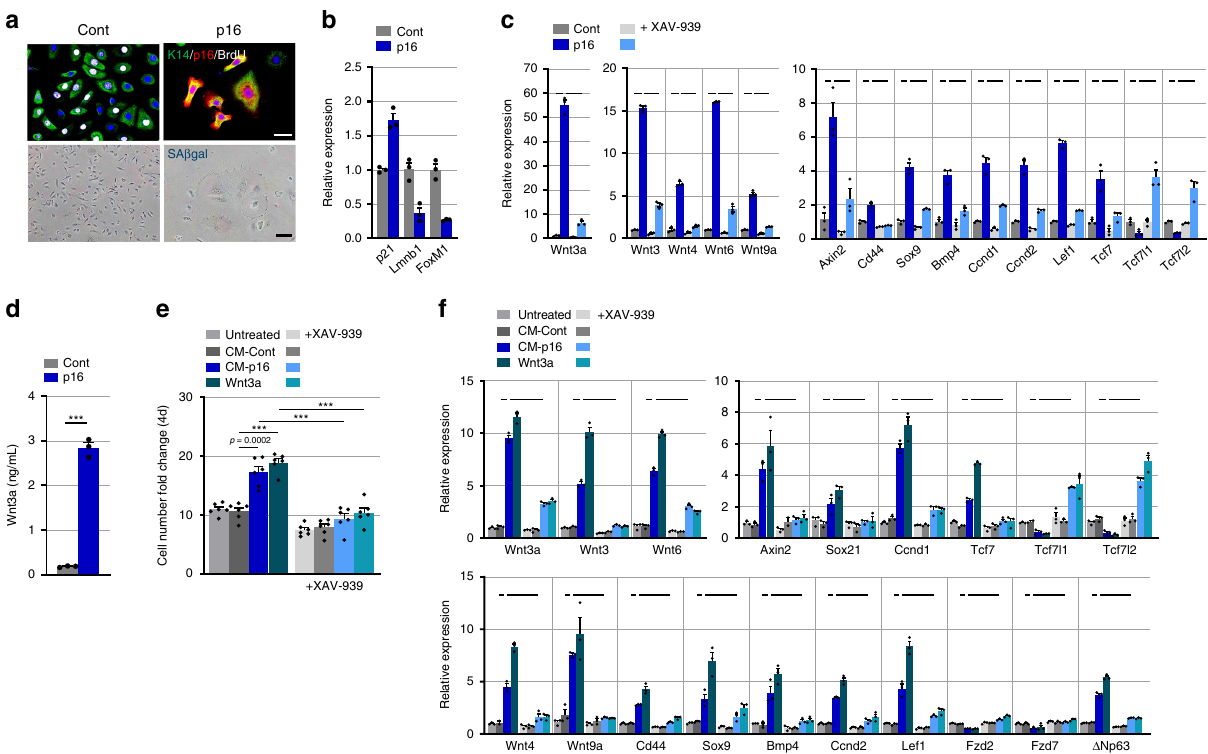
Fig. 5 p16-overexpressing primary keratinocytes stimulate proliferation of naive cells through Wnt secretion. a Primary mouse keratinocytes infected with a p16-expressing or control lentivirus, co-stained for K14 (green), p16 (red) and BrdU (indicating S-phase, white), or for SA- β Gal, 10 days after infection. b Relative mRNA levels of the indicated genes in the same keratinocytes, measured by qRT-PCR. n = 3 replicates. P < 0.05 for all genes. c Relative mRNA levels of the indicated Wnt-associated genes measured by qRT-PCR in control and p16-expressing keratinocytes. Values are also shown for the same cells treated with the β -catenin inhibitor XAV-939 (5 μ M) for 24 h. n = 3 replicates. P < 0.05 for all comparisons indicated by lines: p16 versus control (dark blue versus dark grey, short lines), and p16 versus p16 + XAV-939 (light blue versus dark blue, long lines). d Secreted Wnt3a protein levels in medium of control and p16-expressing cells, measured by ELISA. n = 3 replicates. *** P < 0.0001 e Fold increase over 4 days in numbers of primary keratinocytes cultured with conditioned media from p16-expressing (CM-p16) or from control (CM-Cont) keratinocytes, or with 10 ng/ml recombinant Wnt3a, in the absence or presence of XAV-939 (darker and lighter columns, respectively). n = 6 replicates. *** P < 0.0001. f Relative mRNA levels of the indicated Wnt- associated genes measured by qRT-PCR in keratinocytes treated for 24 h with conditioned media from p16-expressing or control cells, or with Wnt3a, in the presence or absence of XAV-939. n = 3 replicates. P < 0.05 for all comparisons indicated by lines: CM-p16 versus CM-Cont (dark blue versus dark grey, short lines), and CM-p16 versus CM-p16 + XAV-939 (light blue versus dark blue, long lines). All graphs indicate mean across replicates± S.E.M., t test. Scale bars — 50 μ